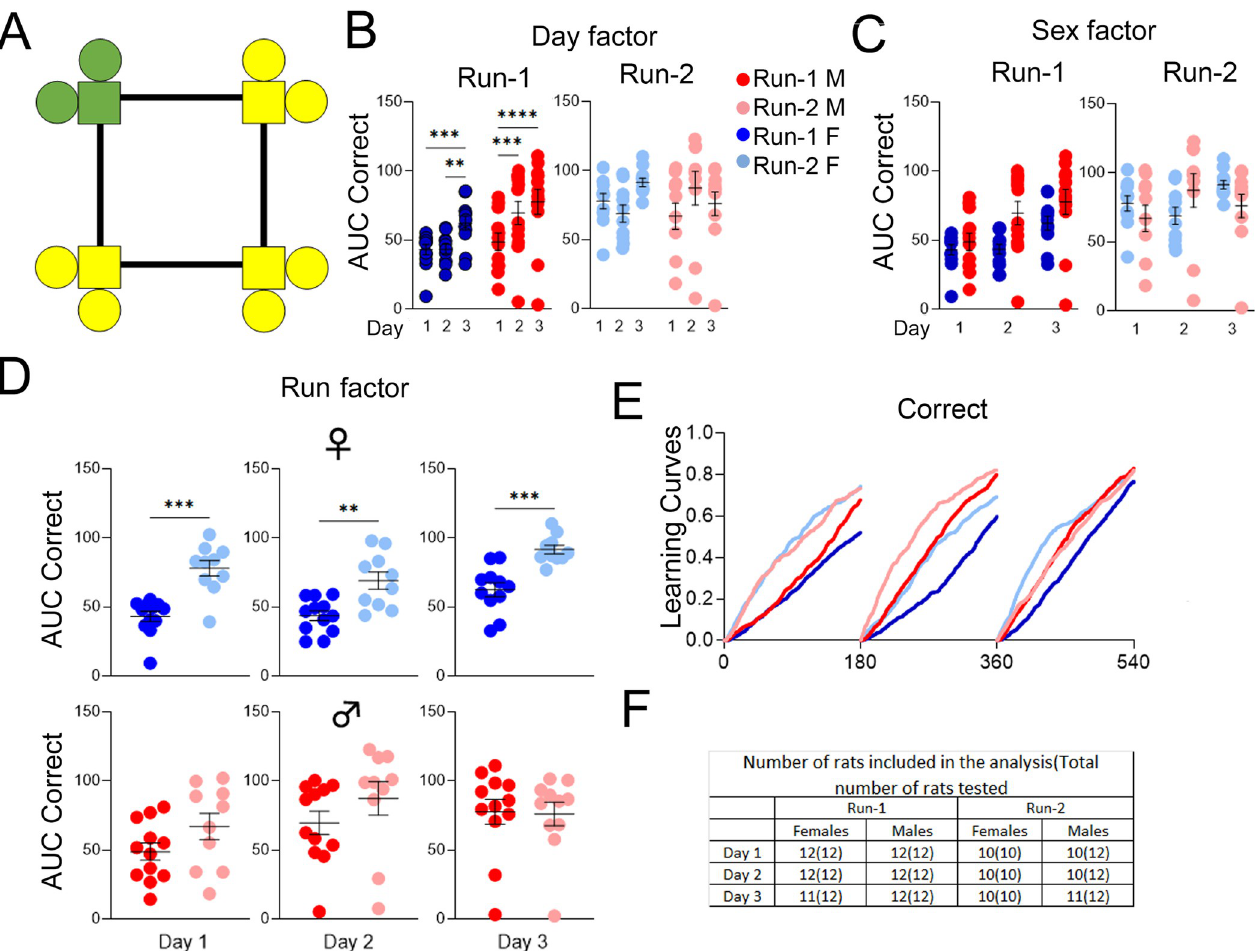
Fig 4. Place learning, cohort A. (A) Example of correct (green) and incorrect (yellow) corner layout for a rat assigned to corner 4. (B) Day factor, (C) Sex factor and (D) Run factor comparisons of area under the curve (AUC) for correct visit learning curves of individual animals by sex, program day, and Run. (E) Learning curves showing the fractional accumulation (y-axis) of correct visits over drinking session time (x-axis), reset every 180 minutes, by sex and Run. (F) For Run-1, 12 male and 12 female rats were tested. All 24 rats were included in the analysis of Run-1. For Run-2, 12 male and 10 female rats were tested, since two females died during the time between Runs. During Run-2, two males were excluded from the analysis of day 1 and 2, and one male was excluded from the analysis of day 3. These animals were excluded because they visited corners less than 25 times during the drinking session. All data represented as mean ± SEM ( � p < 0.05, �� p < 0.01, ��� p < 0.001, ���� p < 0.0001). See Tables 4 and 5 for statistical analysis. Males (M or ♂ ) are colored as red (Run-1) and light red (Run- 2). Females (F or ♀ ) are colored as blue (Run-1) or light blue